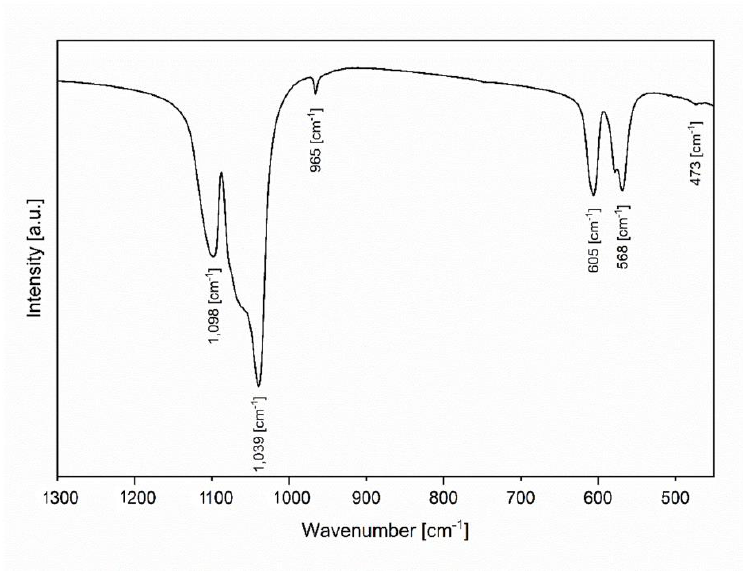
Figure 3. Fourier-transform infrared (FT-IR) spectrum of nanofluorapatite.